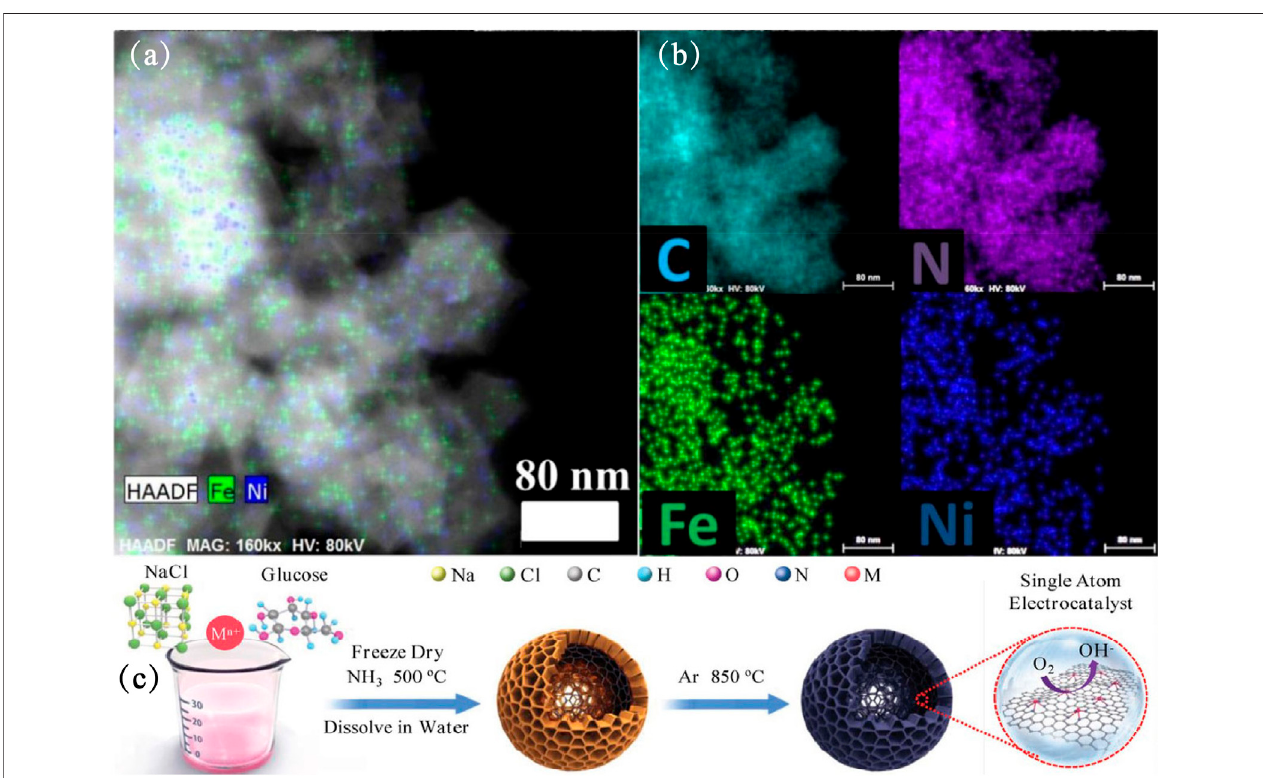
FIGURE 4 | (A,B) HAADF-STEM of FeNi-N 6 and corresponding element mapping patterns of FeNi-N 6 (Zhou et al., 2020). Copyright 2020, American Chemical Society. (C) Schematic illustration for preparing M1-HNC-500-850 (Zhang et al., 2020c). Copyright 2020, Wiley.